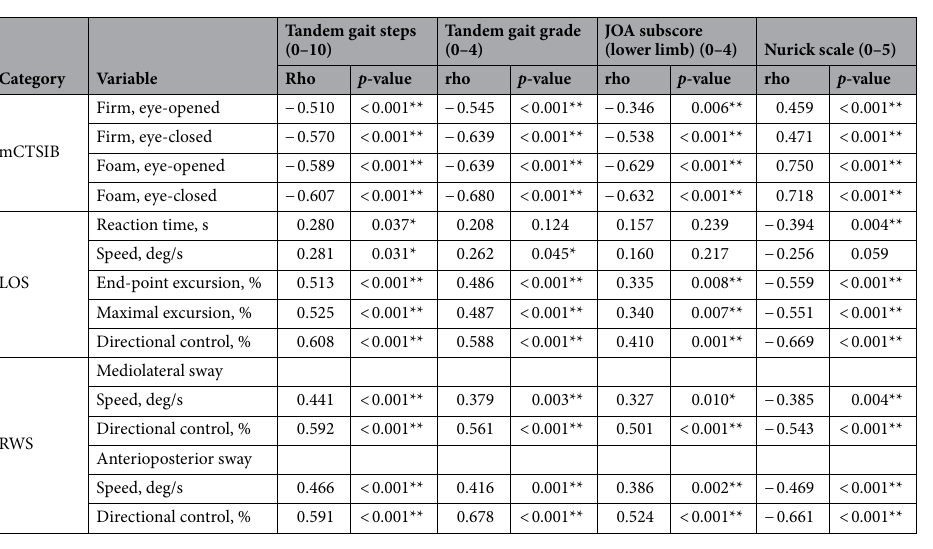
Table 4. Correlation between balance parameters of static and dynamic stability and tandem gait steps/grade, JOA subscore and Nurick scale. *p < 0.05, **p < 0.01. rho = Spearman’s correlation coefficient. JOA Japanese Orthopedic Association, mCTSIB modified clinical test of sensory integration and balance, LOS limits of stability, RWS rhythmic weight shift.